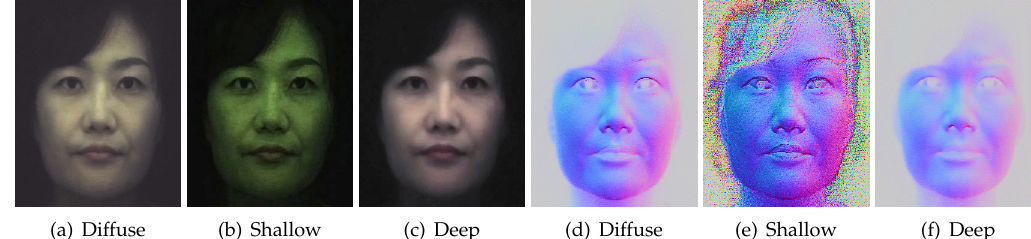
Figure 9. Comparison of albedos ( a – c ) and normal maps ( d – f ) for the diffuse component and separated shallow and deep scattering (( c ) Eurographics Association 2016